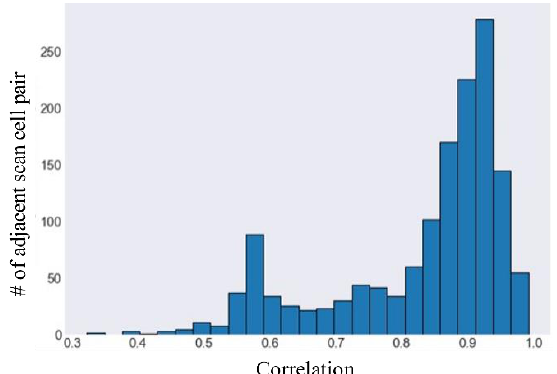
Figure 2. Correlation distribution of adjacent scan cells in s38584.